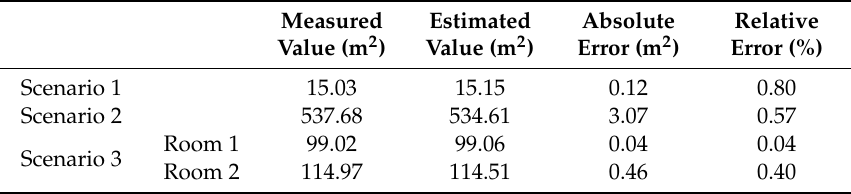
Table 4. Area comparison between the estimated models and the manually generated.